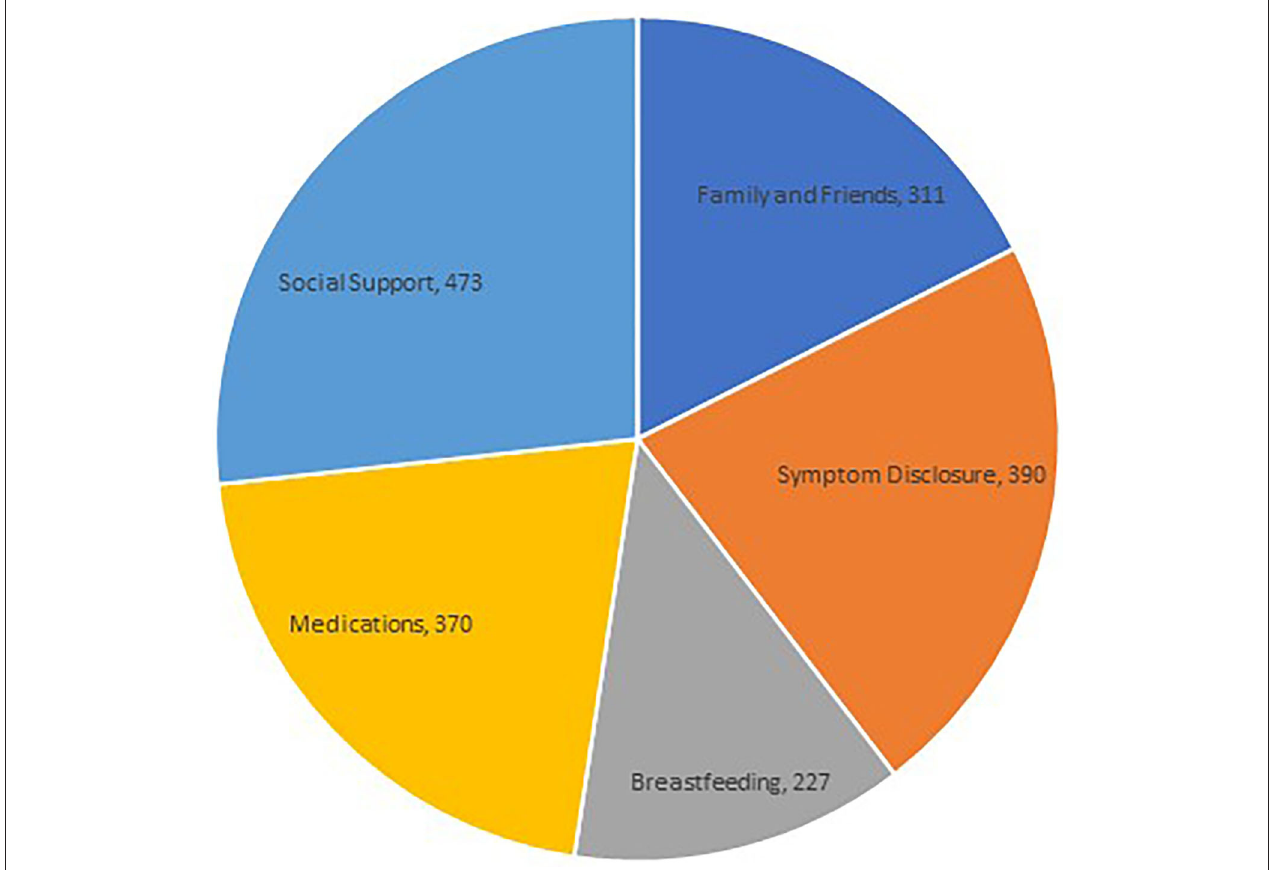
FIGURE 2 | Thematic distribution of PPD-related online social interactions using manual coding.